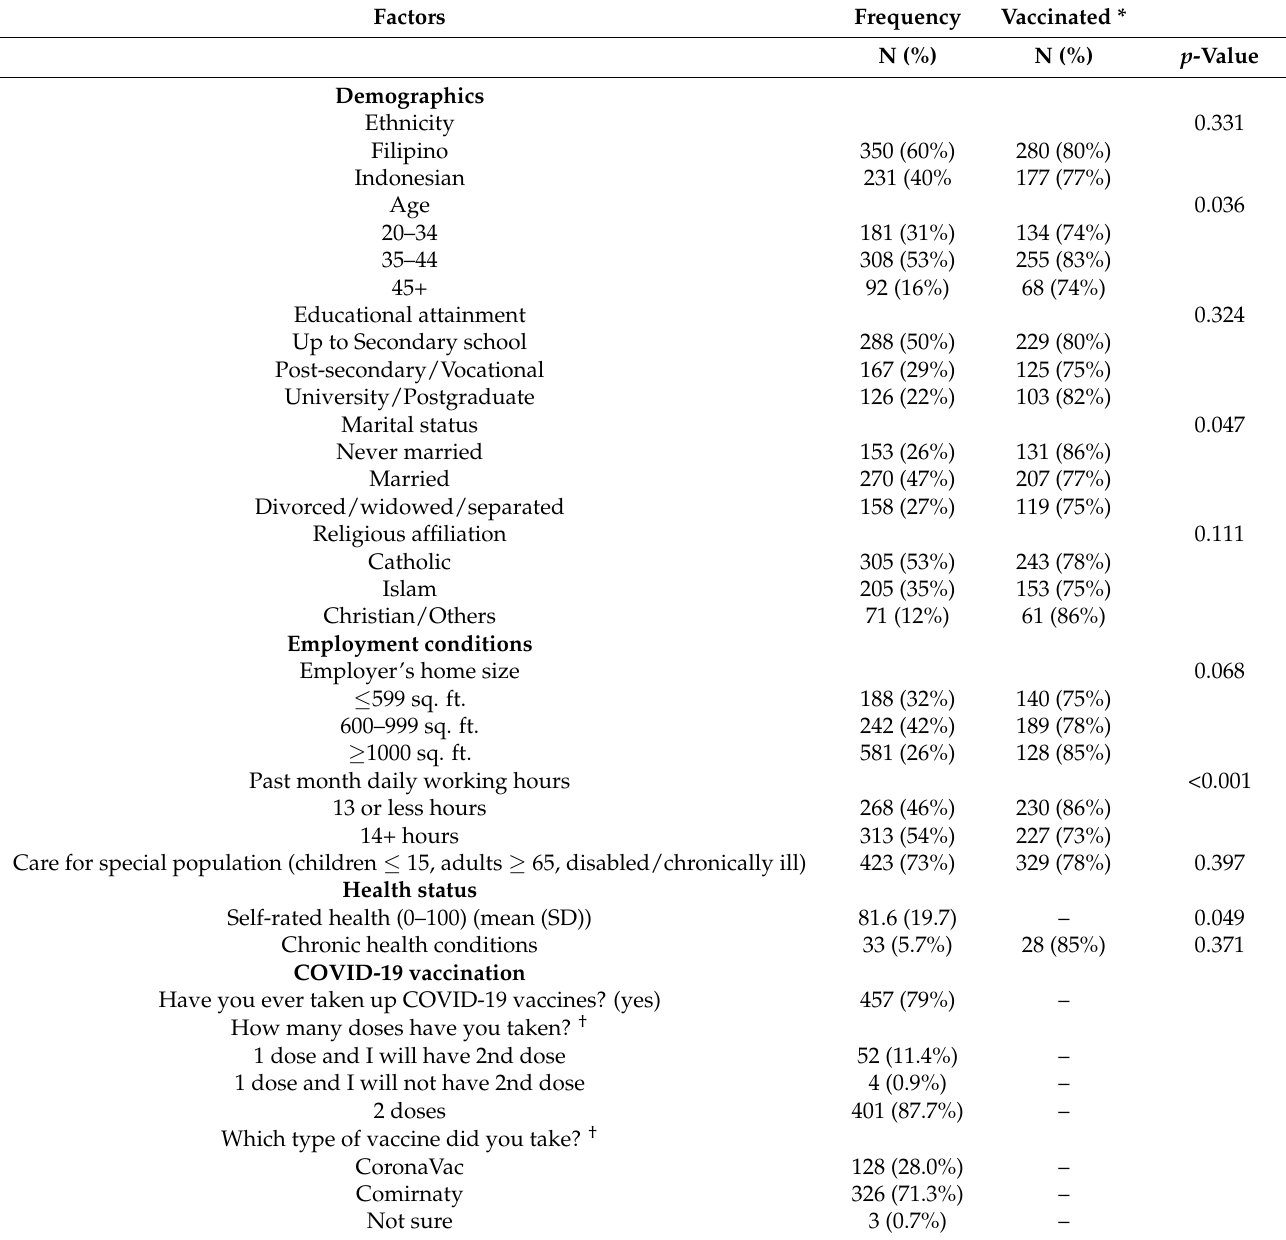
Table 1. Characteristics among study sample ( n =